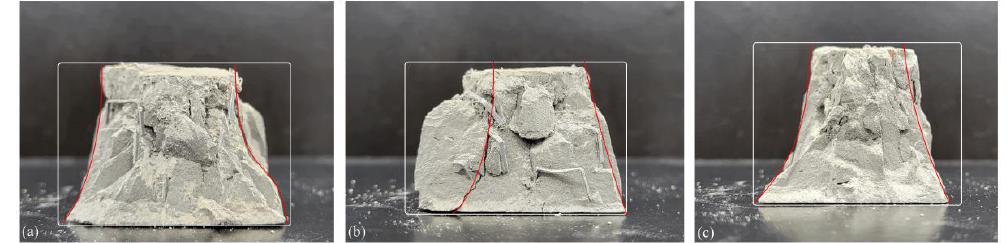
Figure 14. Failure photos of the IR- series samples: ( a ) IR-2, ( b ) IR-6, and ( c ) IR-1.